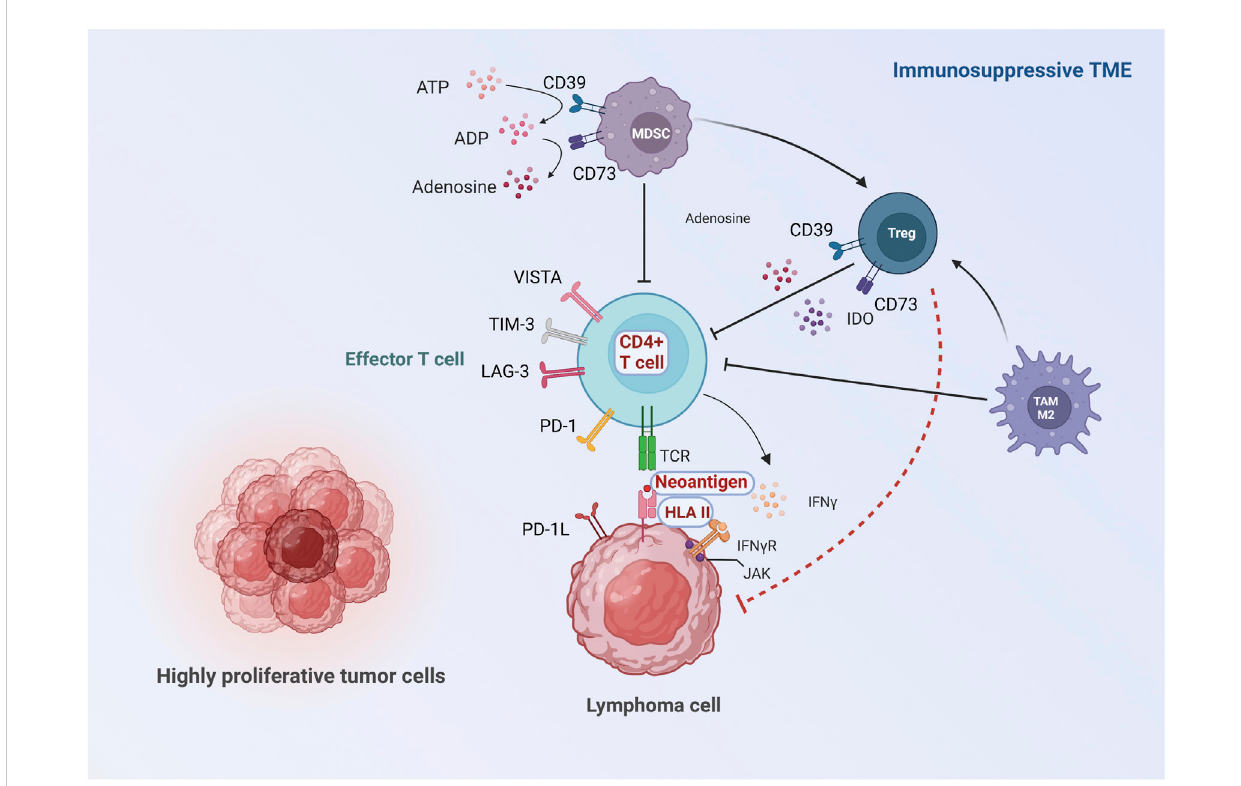
FIGURE 1 Proposed roles of TME in the mechanisms of ICI resistance. The immune response against lymphoma cells starts in the TME where neoantigens released bylymphoma cellsare capturedbyantigen-presentingcells, followedbyantigen presentation toTcells. Activated Tcells killlymphomacells via IFN- γ signaling pathway. Inadequate activation and impaired function of effector T cells can be caused by insuf fi cient neoantigen, aberrant HLA expression and defective IFN- γ signaling pathway. Moreover, the activation of effector T cells is inhibited by upregulation of other inhibitory checkpoint molecules, immunosuppressive metabolites and pro-tumorigenic cell populations in the TME. The major differences between lymphoma and solid cancer are highlighted: 1) The main effector T cells are CD4+T cells instead of CD8+T cells in some subtypes of lymphoma, and resistance to ICIs can be induced by aberrant expression of HLA II. Moreover, the characteristics of neoantigens in lymphoma are distinct from solid tumor. (Showed with red characters with white background). 2) Tregs may be anti-tumorigenic in some lymphoma subtypes, possibly due to the direct suppression of lymphoma cells (showed with red dash